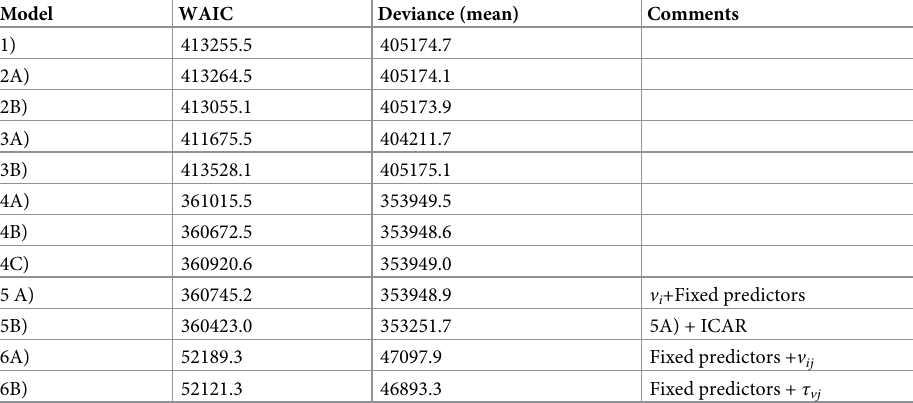
Table 6. New Jersey initial count data daily Poisson